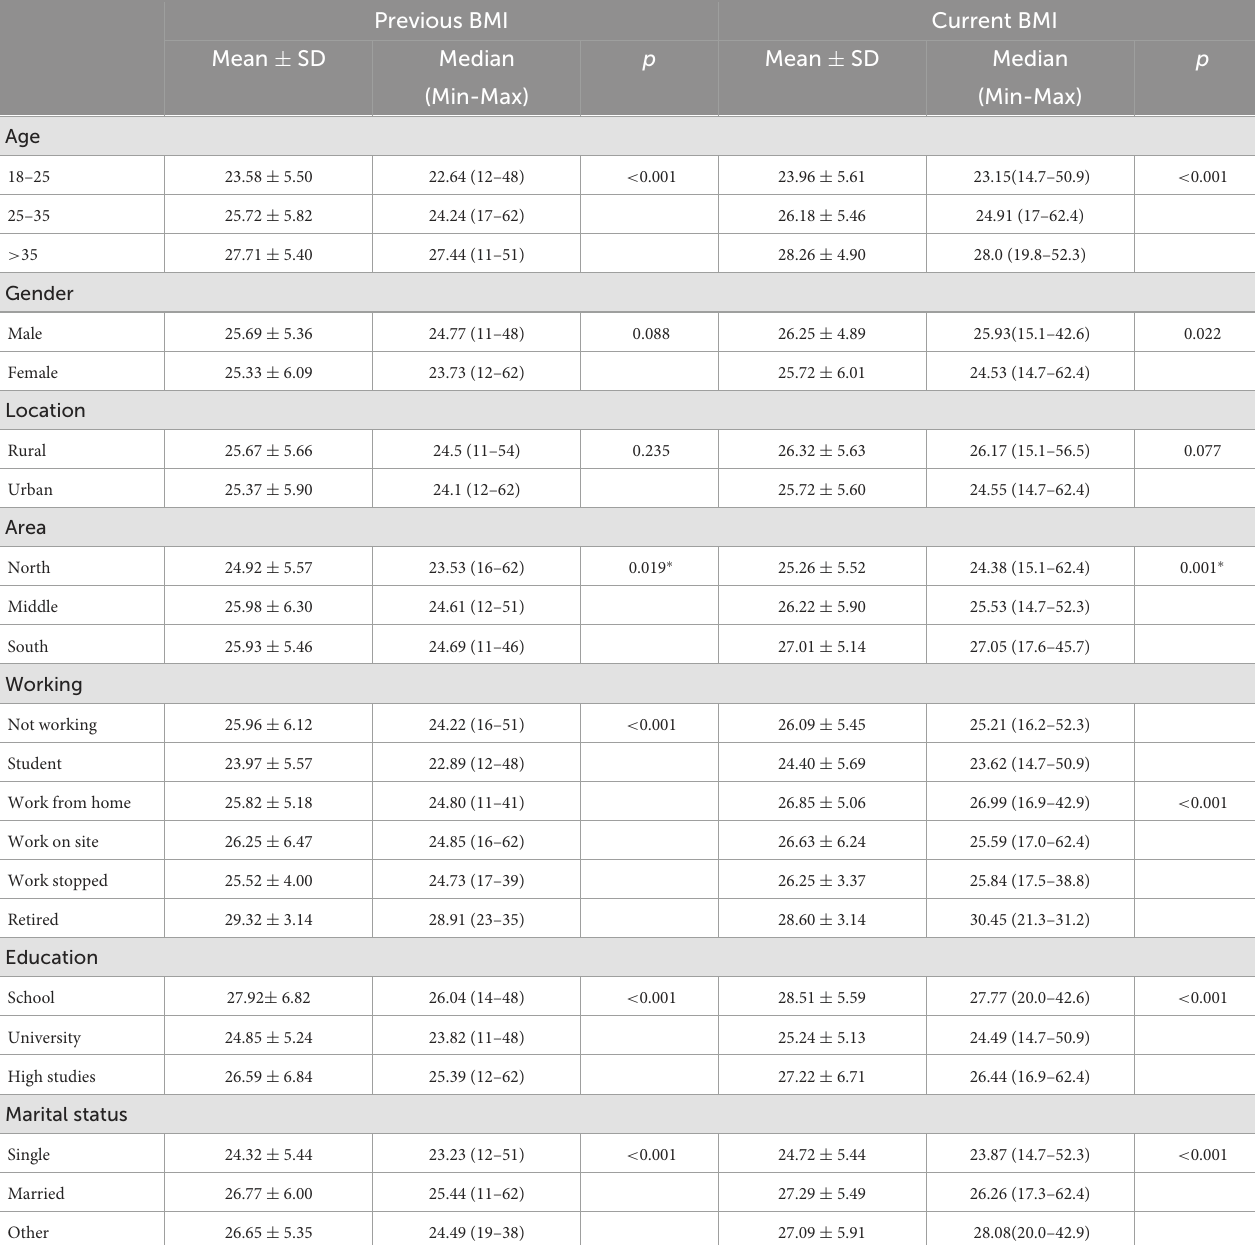
TABLE 6 Kruskal-Wallis and Mann-Whitney U -test of BMI before and during COVID-19 and socio-demographic variables in